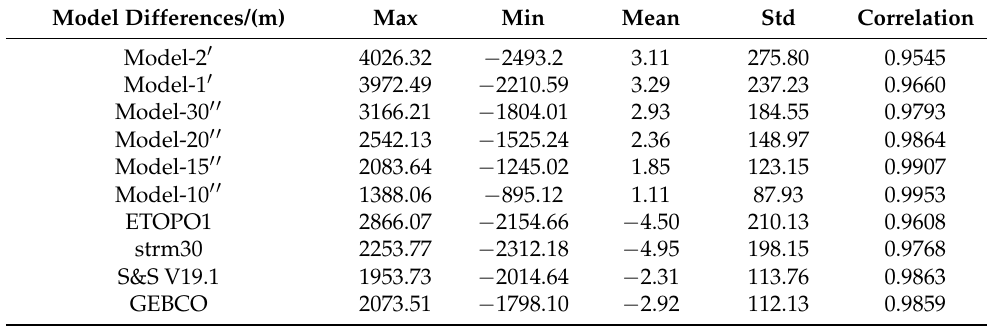
Table 4. The difference between terrain and NGDC grid topography at different resolutions